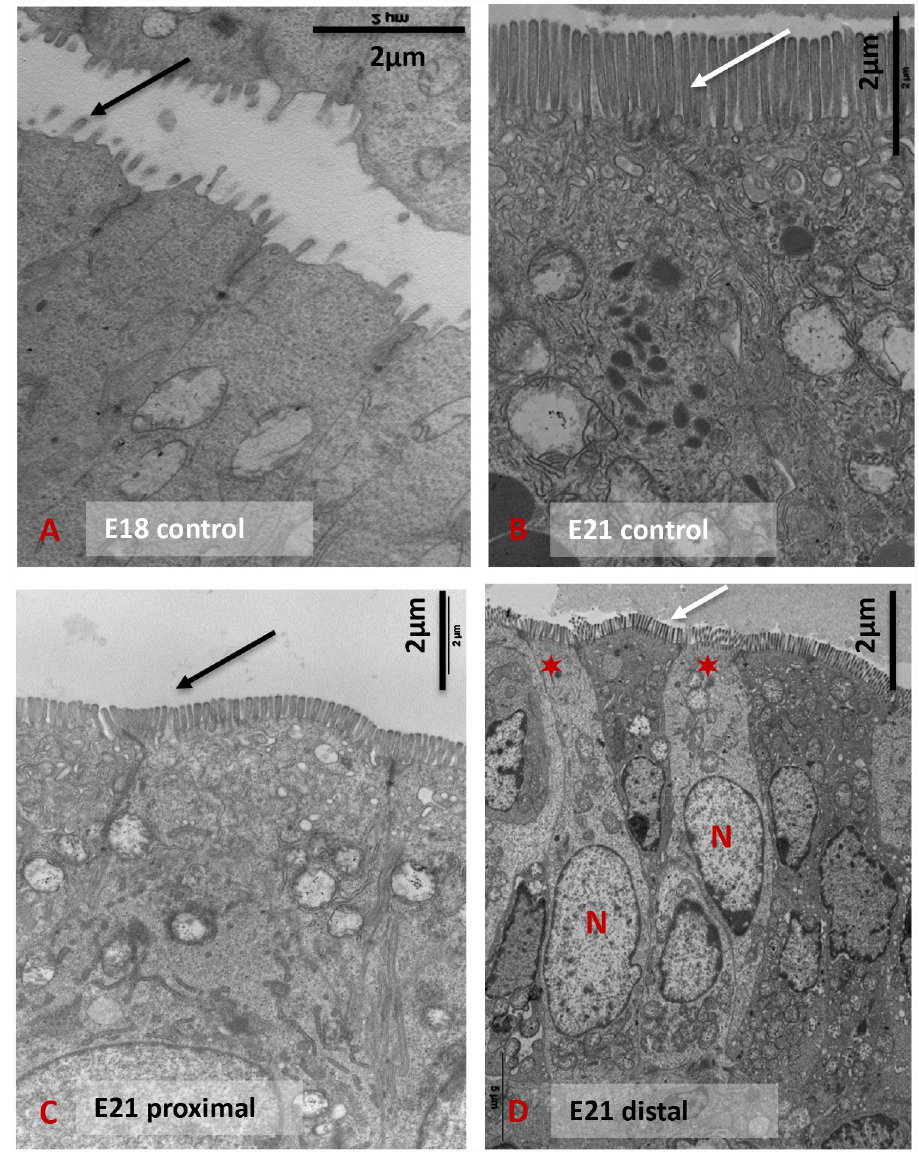
Fig 1. The ultrastructure of enterocytes. Electron microscopy focusing on enterocytes with microvilli on the apical surface of E18 controls (A), E21 controls (B), E21 proximal segment (C), and E21 distal segment (D). N indicates cell nuclei; ✶ indicate immature observed enterocytes and arrows indicate